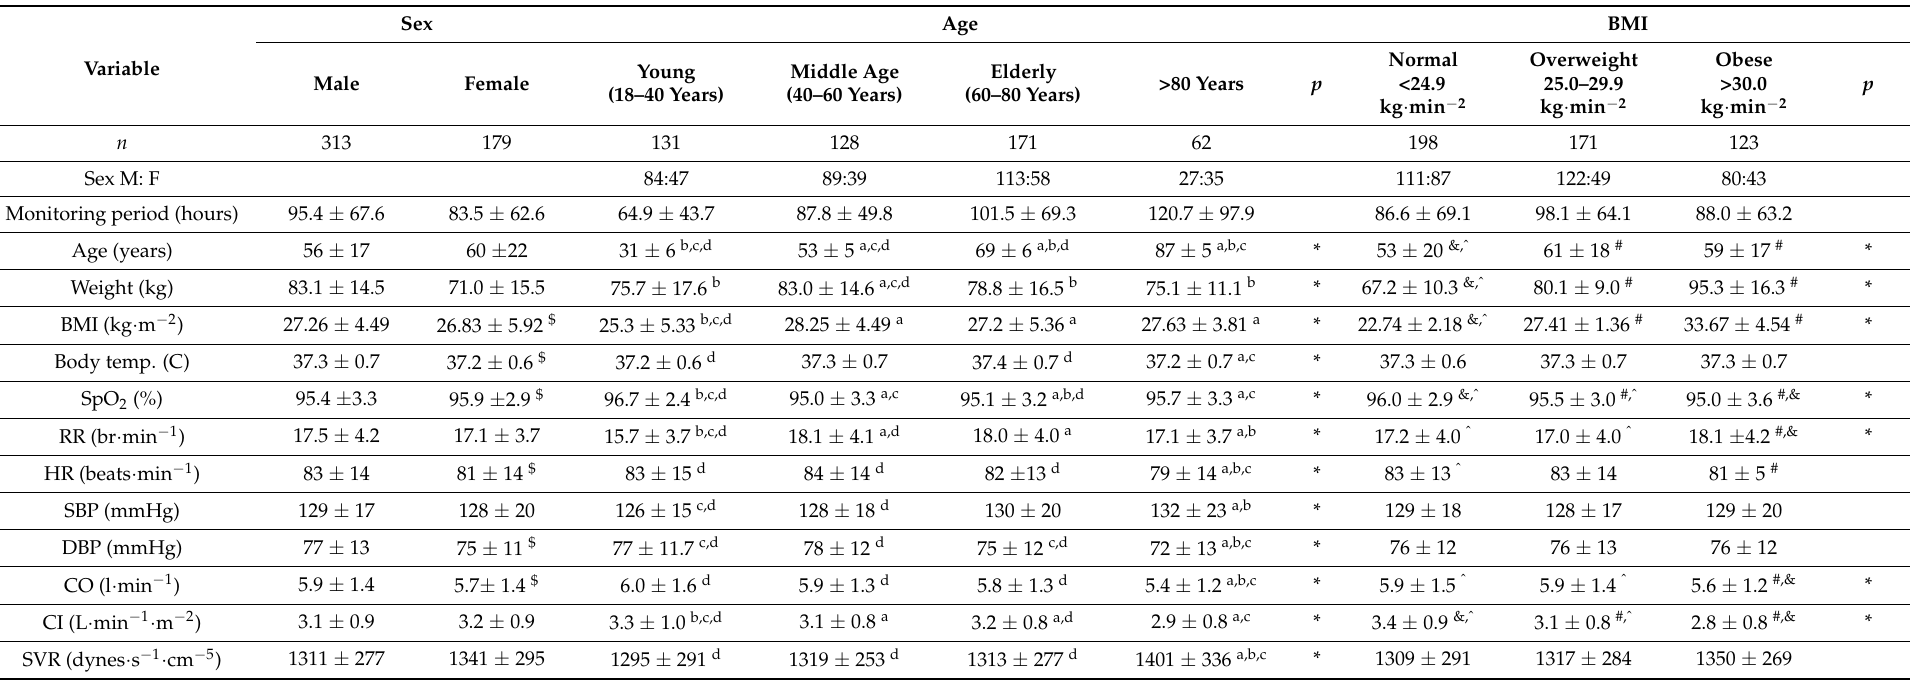
Table 1. Patient characteristics and average values by sub-groups for the first 2 h of